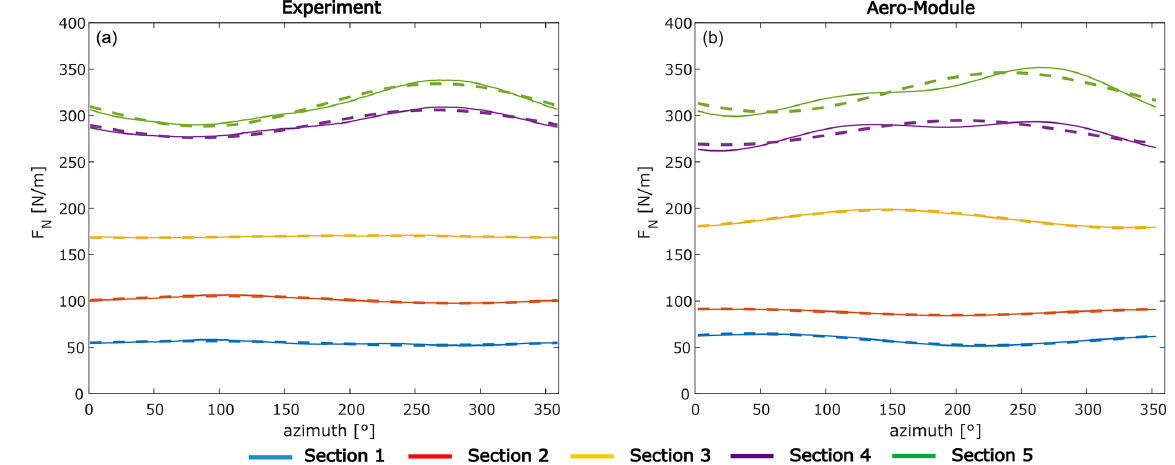
Figure 5. Representation of measurements ( a , solid lines) and Aero-Module output ( b , solid lines) using three Fourier coefficients (dashed) at different radial sections, for scenario S 1 (run 935) of the New MEXICO experiment (last revolution